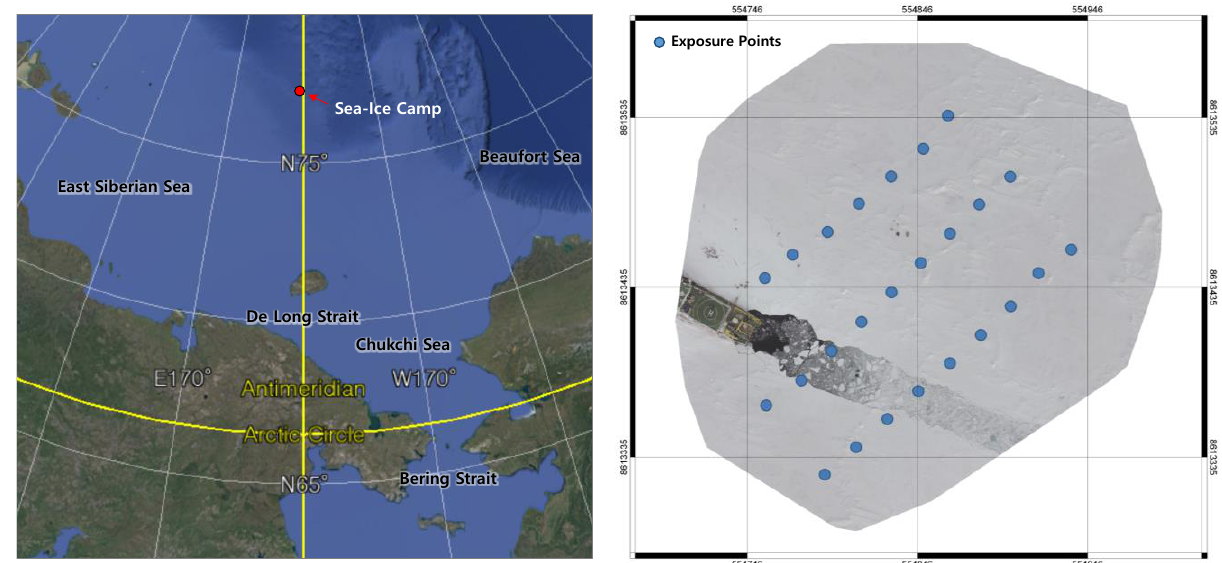
Figure 3. Sea-ice camp and camera exposure points for DSM